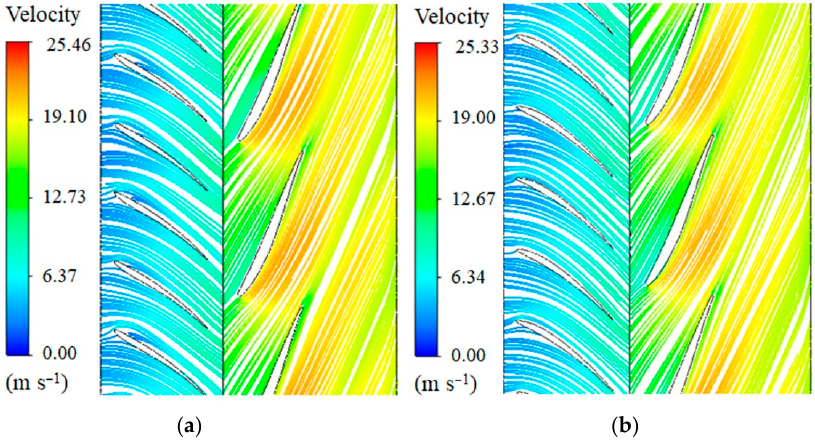
Figure 23. Vane-to-vane streamline distribution of guide vanes and runner vanes: ( a ) streamline distribution before shape change; ( b ) streamline distribution after shape change. Table 8. Performance characteristics according to guide vane shape (short chord, H = 14.84 m).